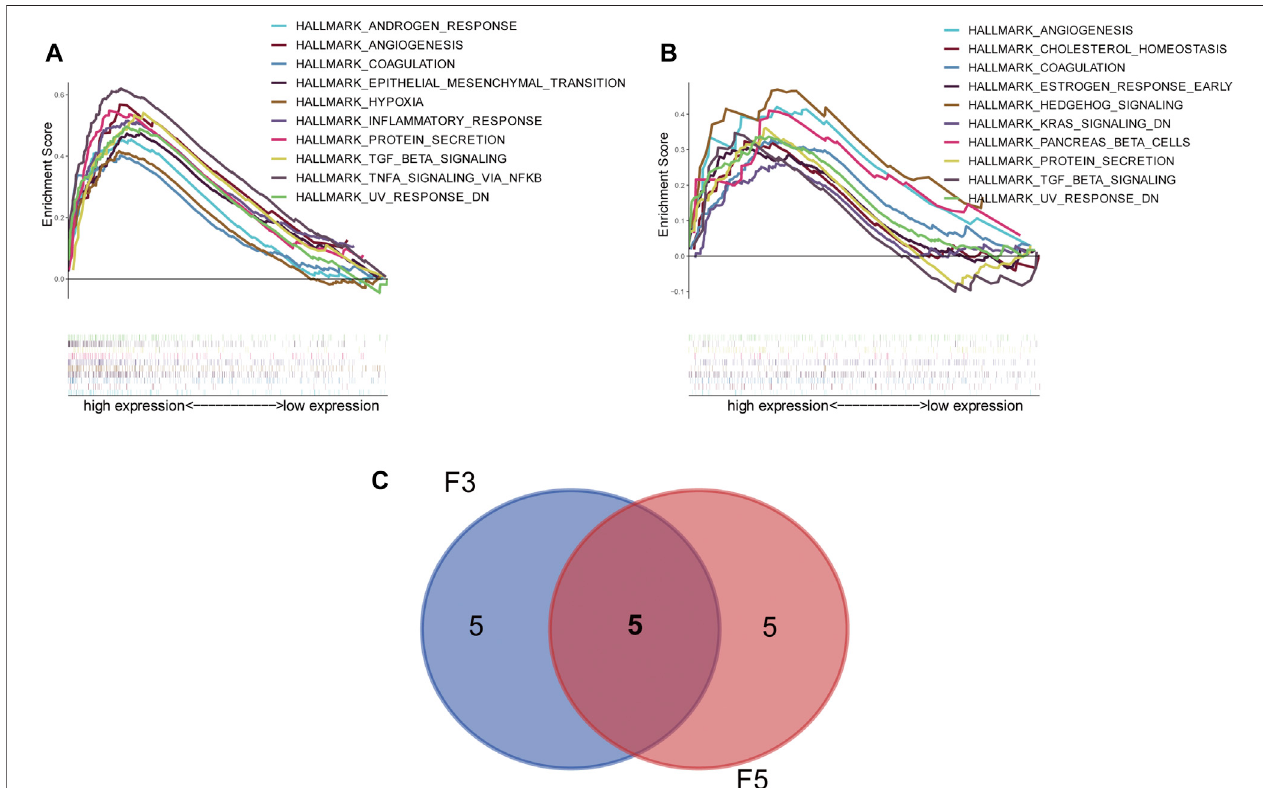
FIGURE 7 | Gene set enrichment analysis (GSEA) reveals the correlation of the D-dimer-related gene expression with several HALLMARK pathways. (A) Multi- GSEAconstructedwithinF3(high vs. low). (B) Multi-GSEAconstructedwithinF5(high vs .low). (C) VennplotdisplayingtheoverlappingpathwaysofF3andF5 — namely, angiogenesis, coagulation, protein secretion, TGF beta signaling and UV response